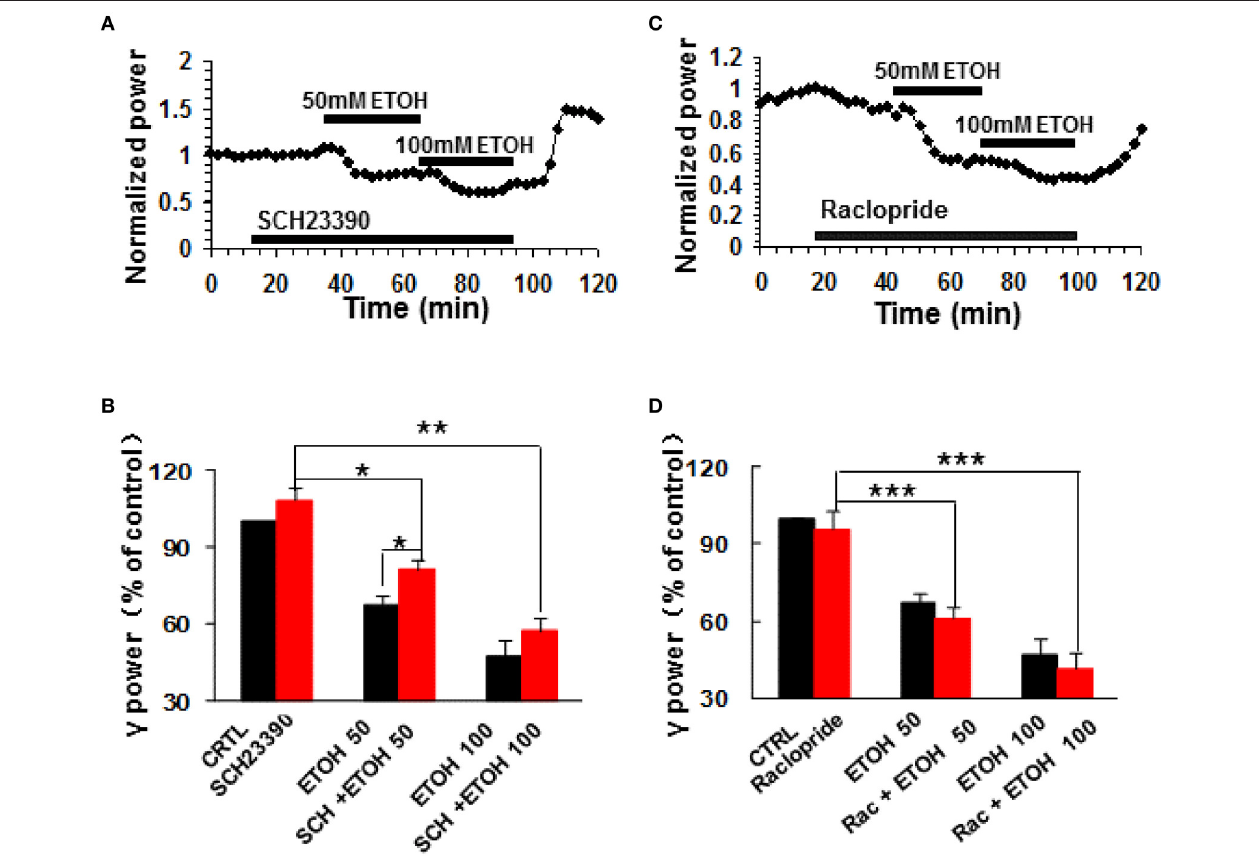
FIGURE 2 | The effects of dopamine receptor antagonists on ethanol-induced suppression of γ oscillations. (A) Example of the time course of γ power, normalized to the γ power during the 5min preceding application of the DR1/5 antagonist, SCH23390 (10 µ M), with additional application of 50mM ethanol followed by 100mM ethanol. (B) γ power as % of baseline ( γ power only in the presence of kainate as control, CTRL) after application of SCH23390, 50 and 100mM ethanol (* P < 0.05; ** P < 0.01; *** P < 0.001, compared with SCH23390 baseline, one-way repeated measures Analysis of Variance (RM ANOVA), n = 11; * P < 0.05 for comparison between ethanol effects in the presence and absence of SCH23390). (C) Example of the effect of ethanol on γ power, in the presence of the DR2/3/4 antagonist raclopride (10 µ M) details as in (A) . (D) γ power as % of baseline for 10 µ M raclopride, 50mM and 100mM ethanol ( n = 8). Details as in (B) .